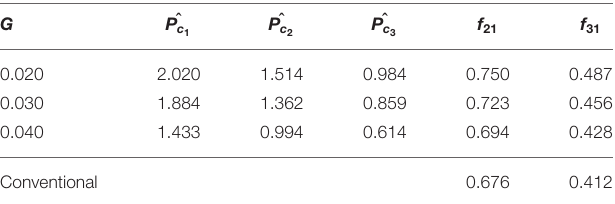
TABLE 2 | The resulting normalized local capillary pressure ( ˆ P c pressure ratios ( f i 1 ) defined in the modified pore-body filling model from LB simulations on PN